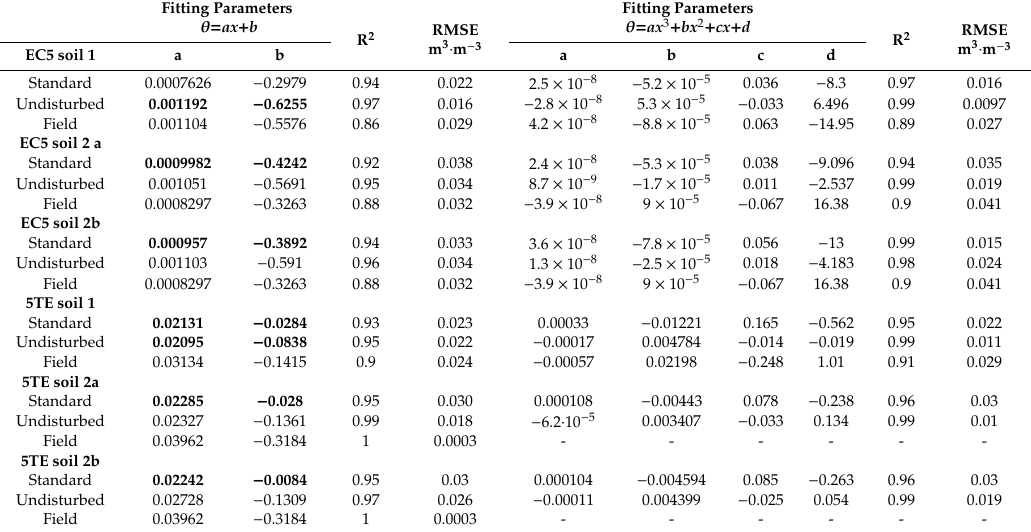
Table 5. Linear and third-order polynomial fitting parameters for the EC5 and 5TE sensors calibration data, obtained by the standard, undisturbed and field calibration methods (the parameters of the equations retained in the subsequent parts are highlighted in